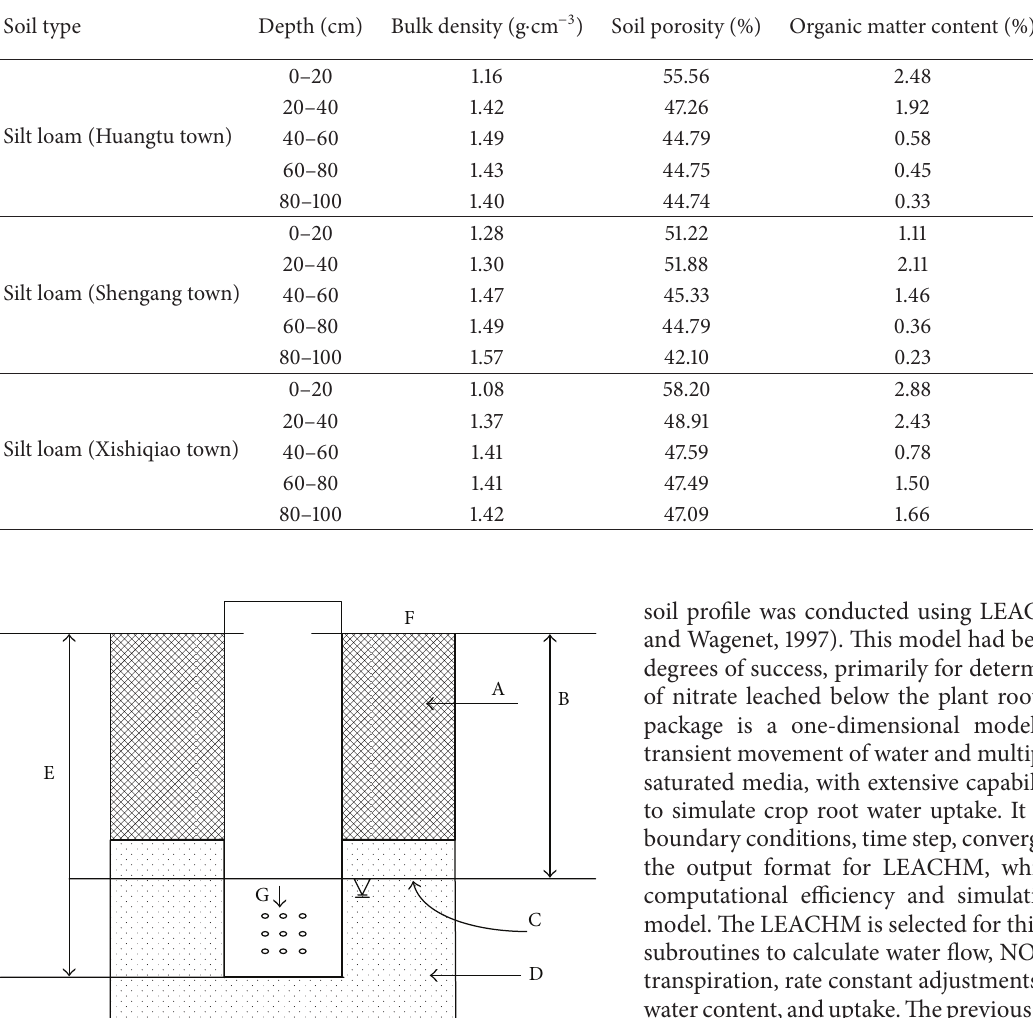
Table 1: Selected physical properties and background values of soil samples.